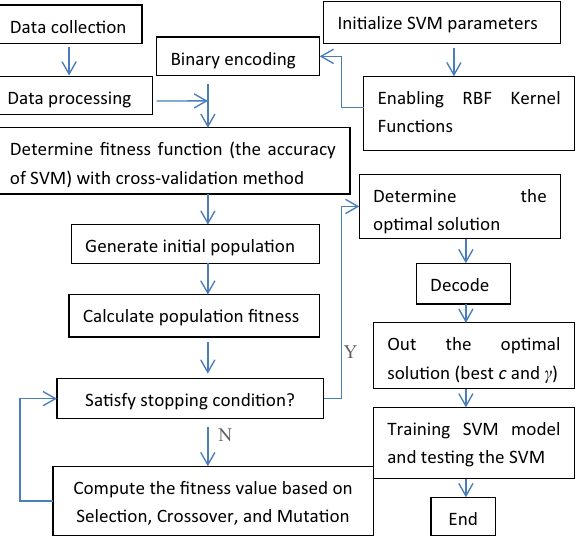
Figure 1. Flow chart of SVM SVM based on genetic